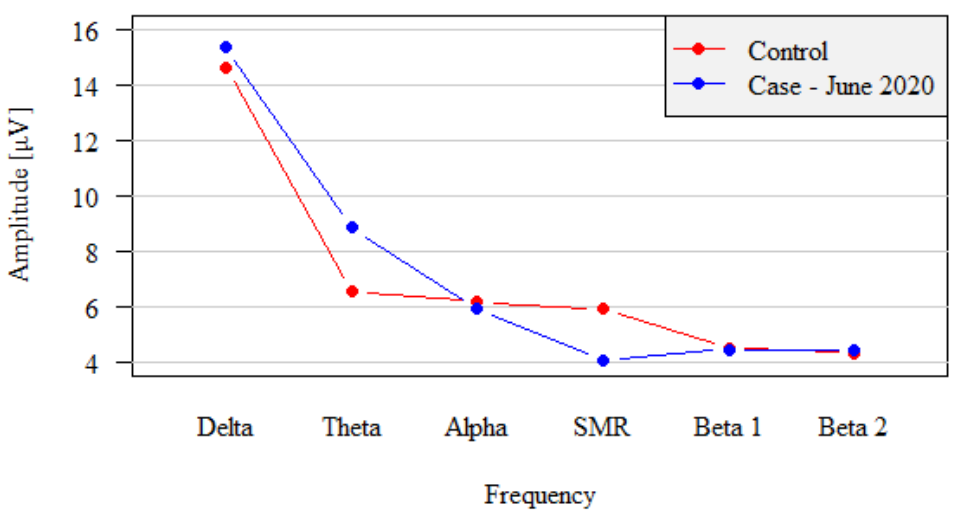
Figure 4. Comparison between right hemispheric (C4) QEEG recordings in test patient with panic attacks after completing the neurofeedback training (blue dots and lines) vs. non-affected subject (control, red dots and lines).